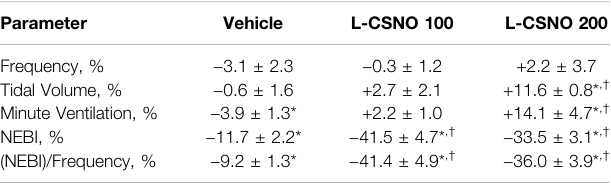
TABLE 3 | Cumulative changes in Pre ventilatory parameters elicited by the continuous intravenous infusion of vehicle or S-nitroso-L-cysteine (L-CSNO) during the 45 min of infusion.